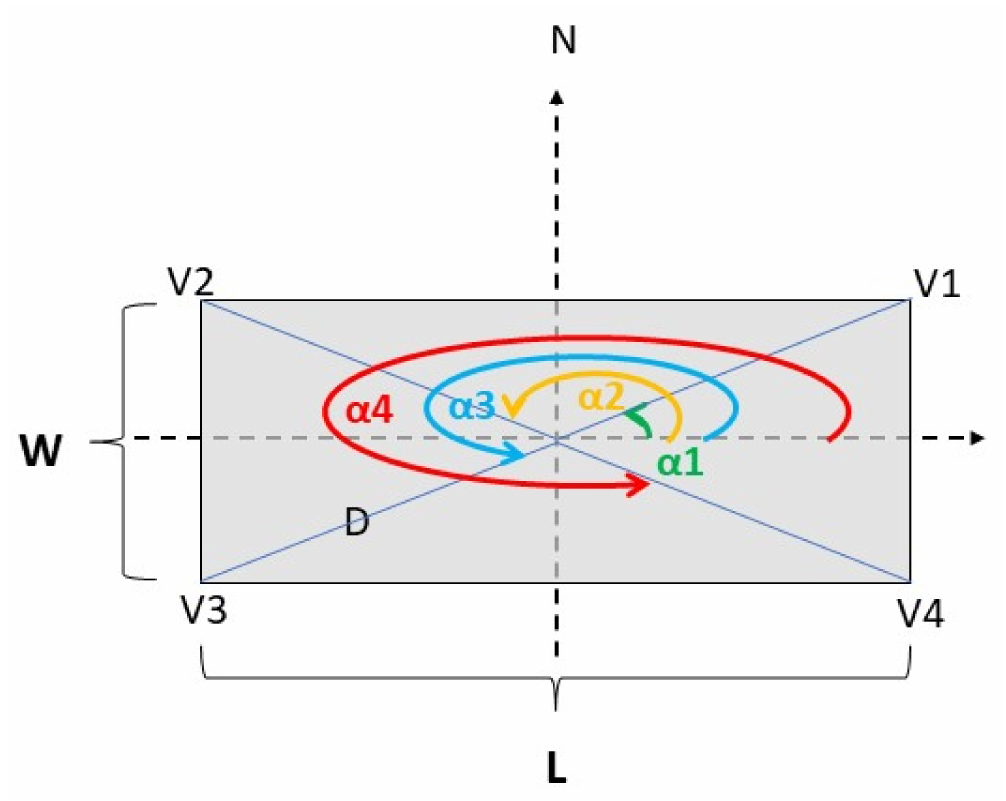
Figure 5. Definition of the limiting angles. Top view of the